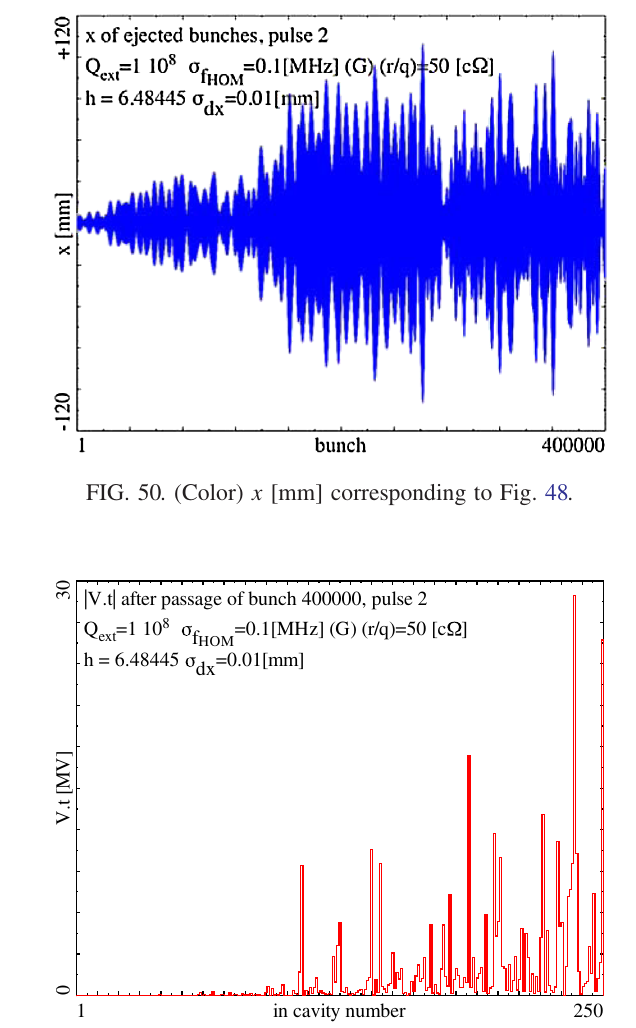
FIG. 51. (Color) Transverse voltage after the last bunch, con- ditions as in Fig. 48.